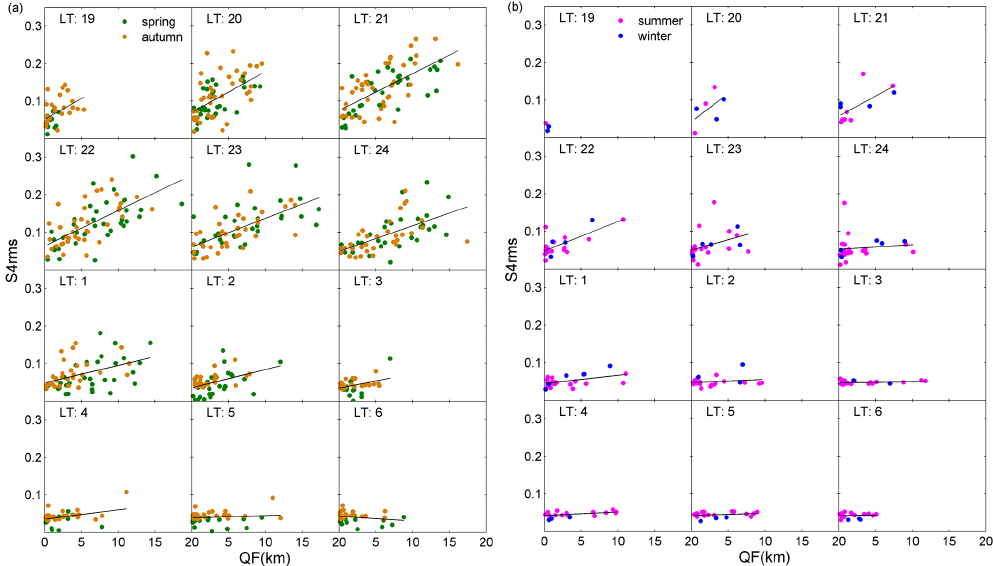
Figure 3. Scatter plots of 1h averaged QF (QFavg) and root mean square of S4max (S4rms) during (a) equinoctial and (b) solstitial months. The solid slant line in each plot is the linear fit of all